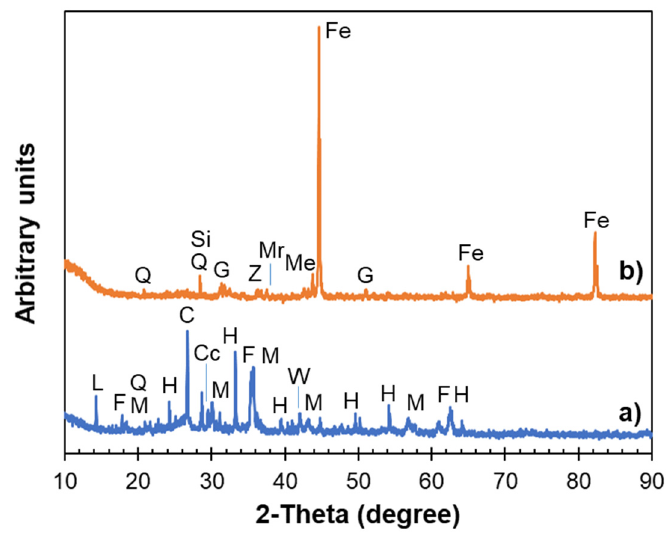
Figure 7. X-ray di ff raction (XRD) pattern of reference sample (C / O = 100%) ( a ) before—see Table 2—and ( b ) after microwave treatment. Q = Quartz, Si = Silicon, Cc = Calcite, G = Gehlenite, Z = Zincite, Mr = Merwinite, Me = Melilite, Fe = Iron, L = Lepidocrocite, F = Franklinite, M = Magnetite, H = Hematite, C = Carbon (graphite), W = Wüstite.